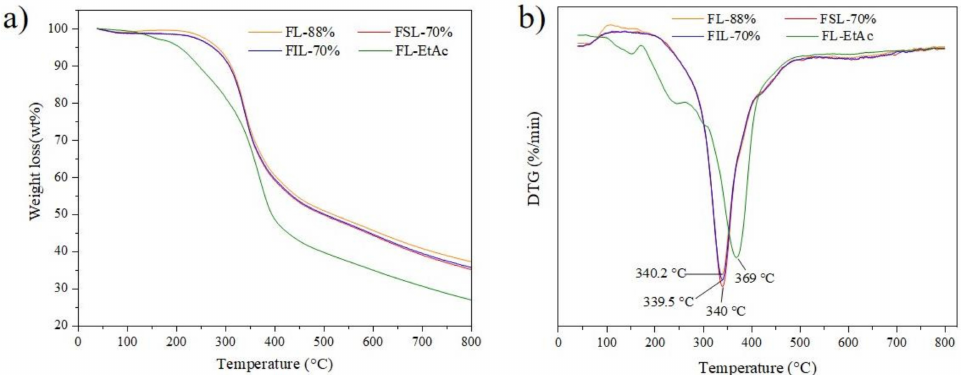
Figure 7. TGA/DTG analysis of lignin samples obtained from two-step formosolv fractionation. ( a ) TGA curves; ( b ) DTG